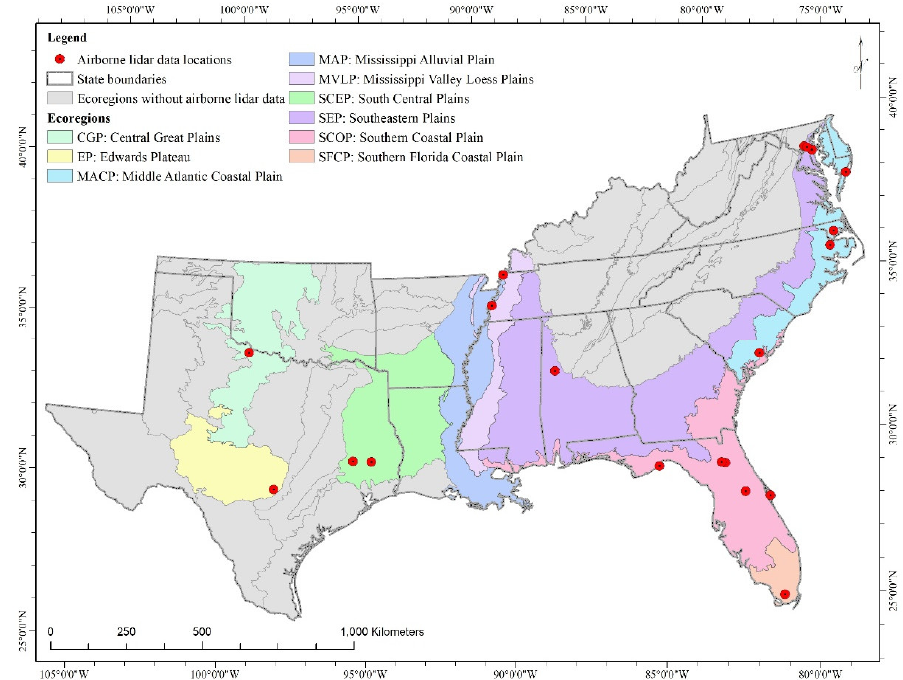
Figure 2. EPA level III ecoregions [20] and airborne lidar point cloud data locations (red dots) superimposed on the states comprising the United States Census Bureau Southern Region. Colored areas represent the effective study area used in this research. Table 1. Ecoregion codes and names, the total number, and the number of regressable cells with ( n ) and without ( n ′) SIM GCHM zeros.